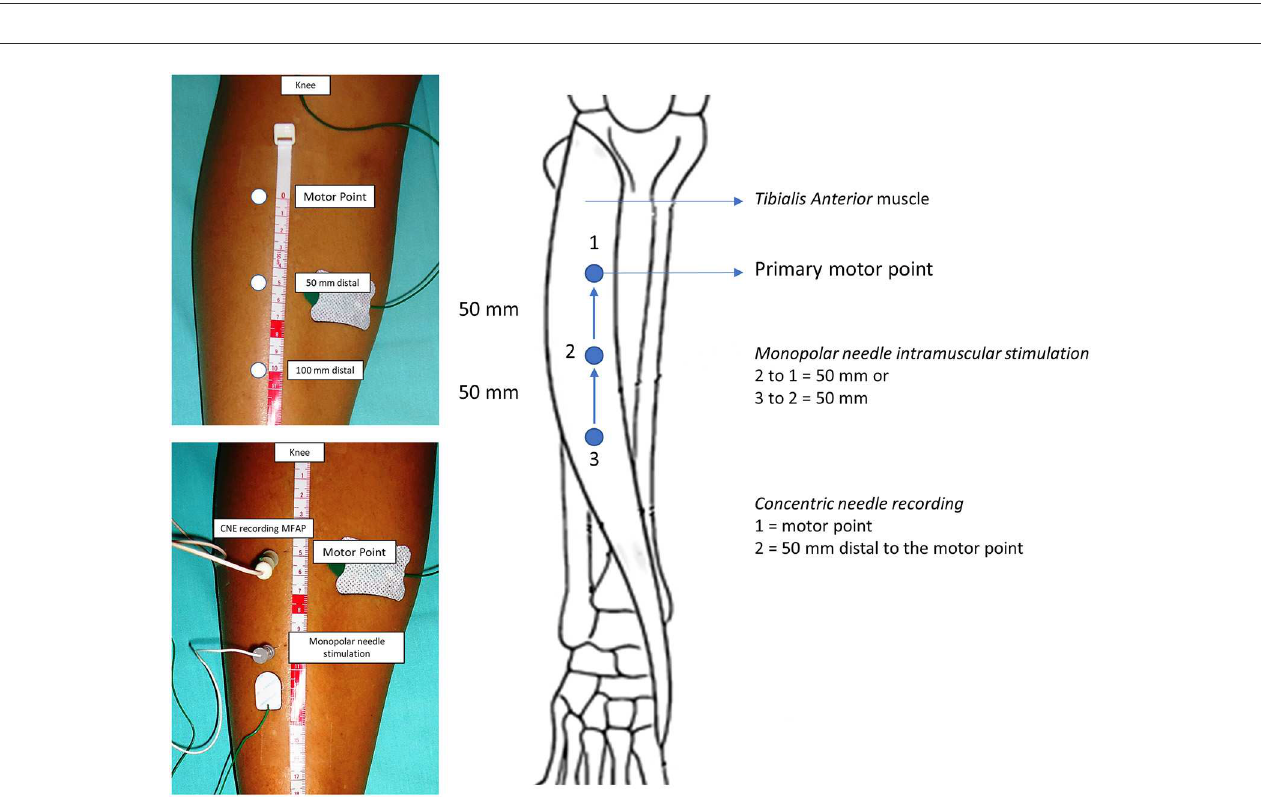
FIGURE2 Tibialis anterior muscle anatomical landmarks for needle insertion. The recorded concentric needle electrode (CNE) is inserted in the motor point or 50mm distal. The monopolar stimulation needle electrode is inserted 50mm distal to the recording CNE. The muscle fiber conduction velocity is reliably calculated if both stimulation and recording needles are inserted and kept at a right